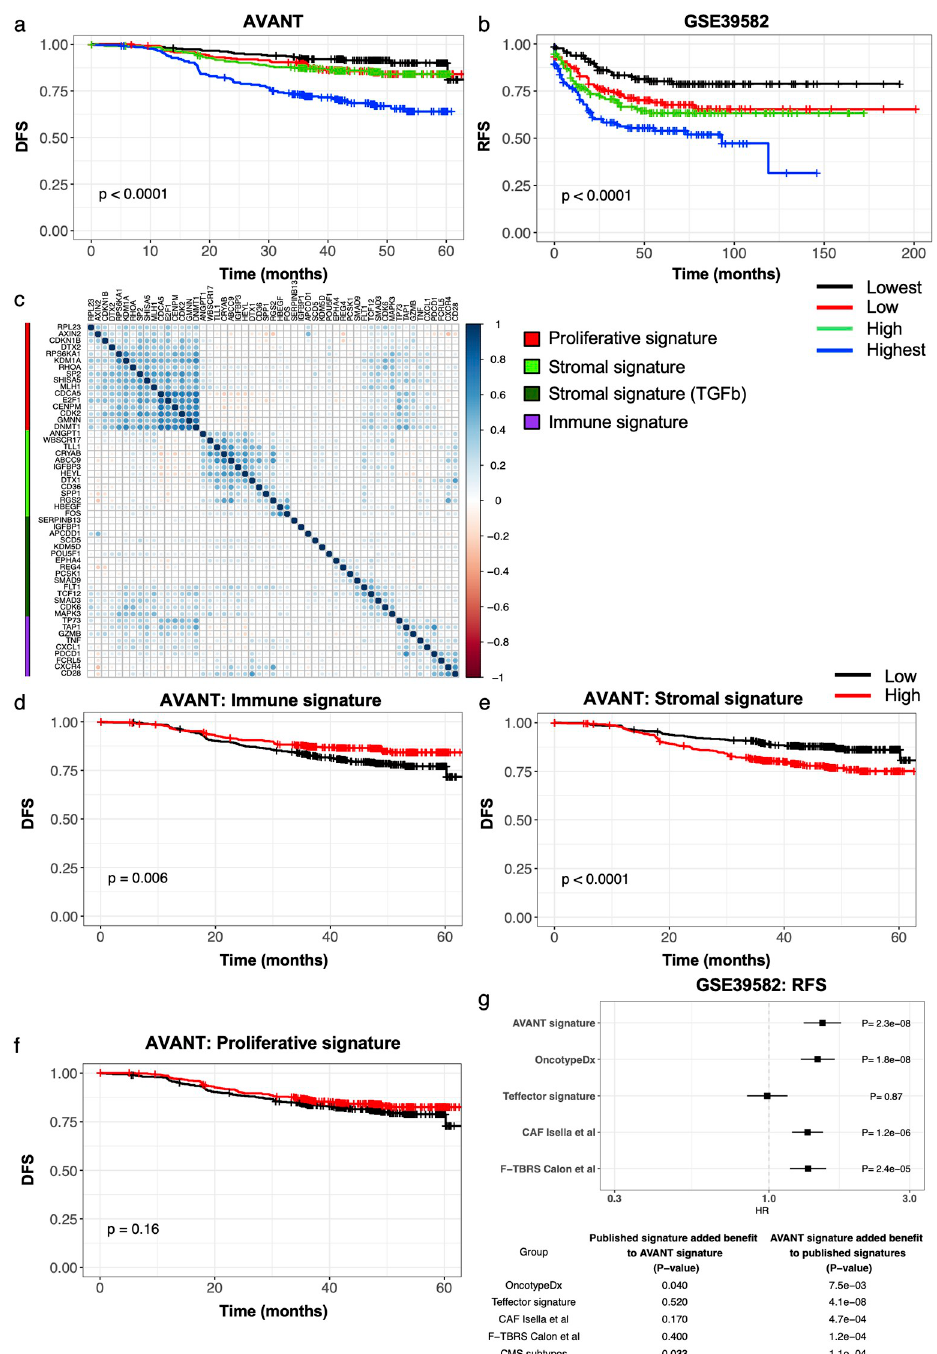
Fig 1. De novo prognostic signature for adjuvant CRC. (a) Kaplan-Meier curves for the AVANT signature in the AVANT BEP dataset for DFS. The p-value corresponds to a log-rank test. (b) Kaplan-Meier curves for the AVANT signature in an independent validation cohort GSE39582 for RFS. (c) Correlation plot for the genes in the AVANT signature. Blue denotes positive and red denotes negative Pearson correlation. Color intensity denotes the strength of the correlation. Signature genes were assigned to one of four clusters. Red denotes proliferative genes, light and dark green denote stromal genes, and purple denotes immune genes. (d-f) Kaplan-Meier curves for the prognosis of (d) the immune genes, (e) stromal genes, and (f) proliferative genes of the AVANT signature divided at the median in the AVANT BEP dataset. (g) RFS forest plot for validation dataset GSE39582 shows hazard ratios and associated p-values for each individual signature. In the table below for GSE39582, column (1) assesses significance of added